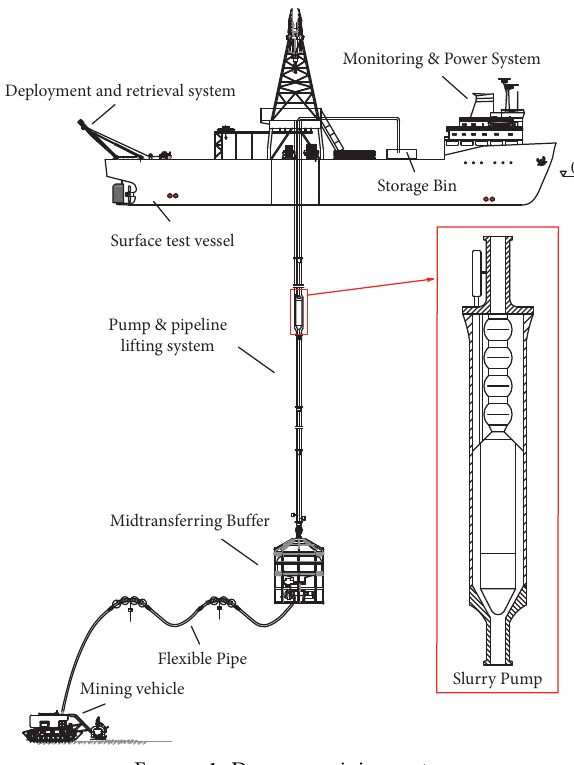
Figure 1: Deep-sea mining system.